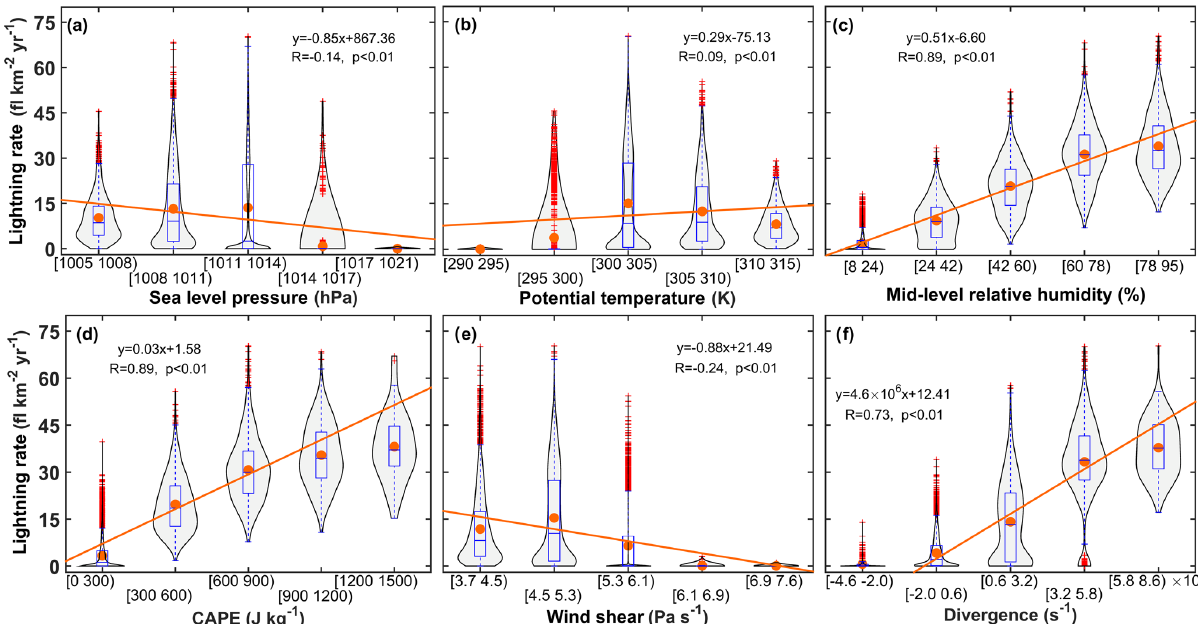
Figure 5. Violin plots of lightning dispersion showing the relationship between the lightning flash rate and six dynamic–thermodynamic variables: (a) sea level pressure, (b) potential temperature, (c) mid-level relative humidity, (d) convective available potential energy (CAPE), (e) vertical wind shear, and (f) 200hPa divergence in the dust-dominant region. The five bins are equally spaced. Box plots represent the interquartile range (the distance between the bottom and the top of the box), the median (the band inside the box), the 95% confidence interval (whiskers above and below the box), the maximum (the end of the whisker above), the minimum (the end of the whisker below), and the mean (orange dot) in each bin. The plus signs represent outliers. On each side of the black line is the kernel estimation showing the distribution shape of the data. The estimate is based on a normal kernel function and is evaluated at 100 equally spaced points. Wider sections of the violin plot represent a high probability that members of the population will take on the given value; the skinnier sections represent a lower probability. The equations describe the linear correlations between the lightning flash rate and the dynamic–thermodynamic variables. Pearson correlation coefficients ( R ), p values, and the linear regression lines (in orange) are also shown. Data used here are from every grid square (2.5 ◦ × 2.5 ◦ ) through the whole year from 2003 to 2013. Dynamic–thermodynamic variables are processed using 3-month running mean filters to match with lightning